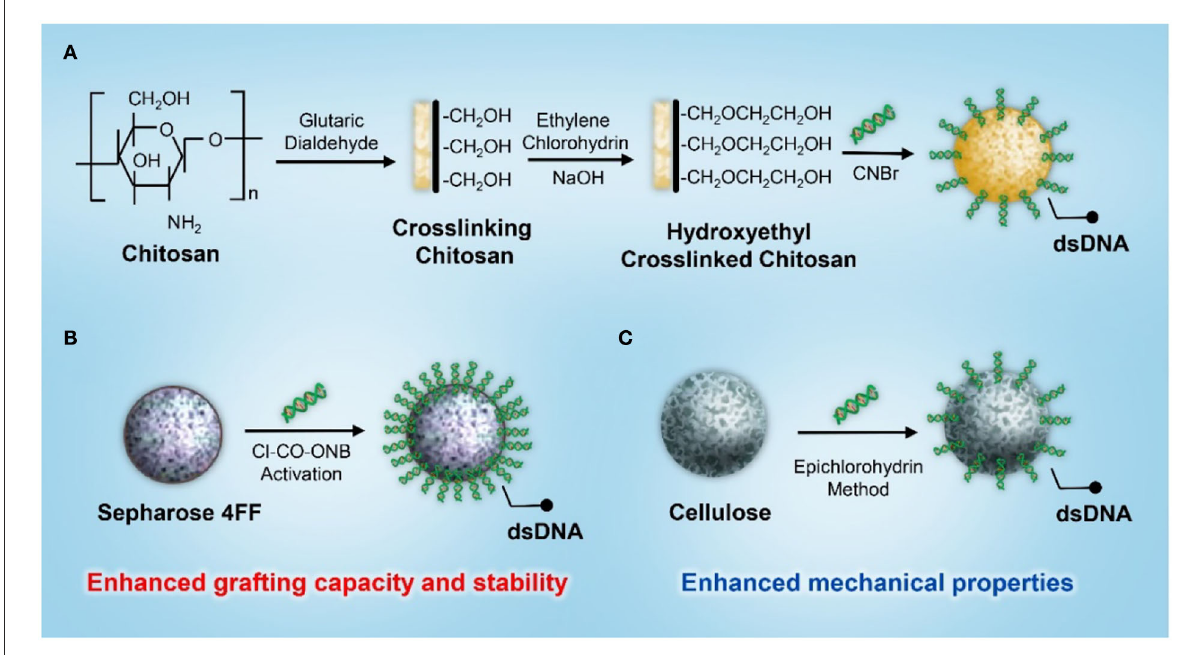
FIGURE4 A schematic illustration of the synthesis of a dsDNA-based immunosorbent using (A) chitosan, (B) Sepharose 4FF, and (C) cellulose as the supporting